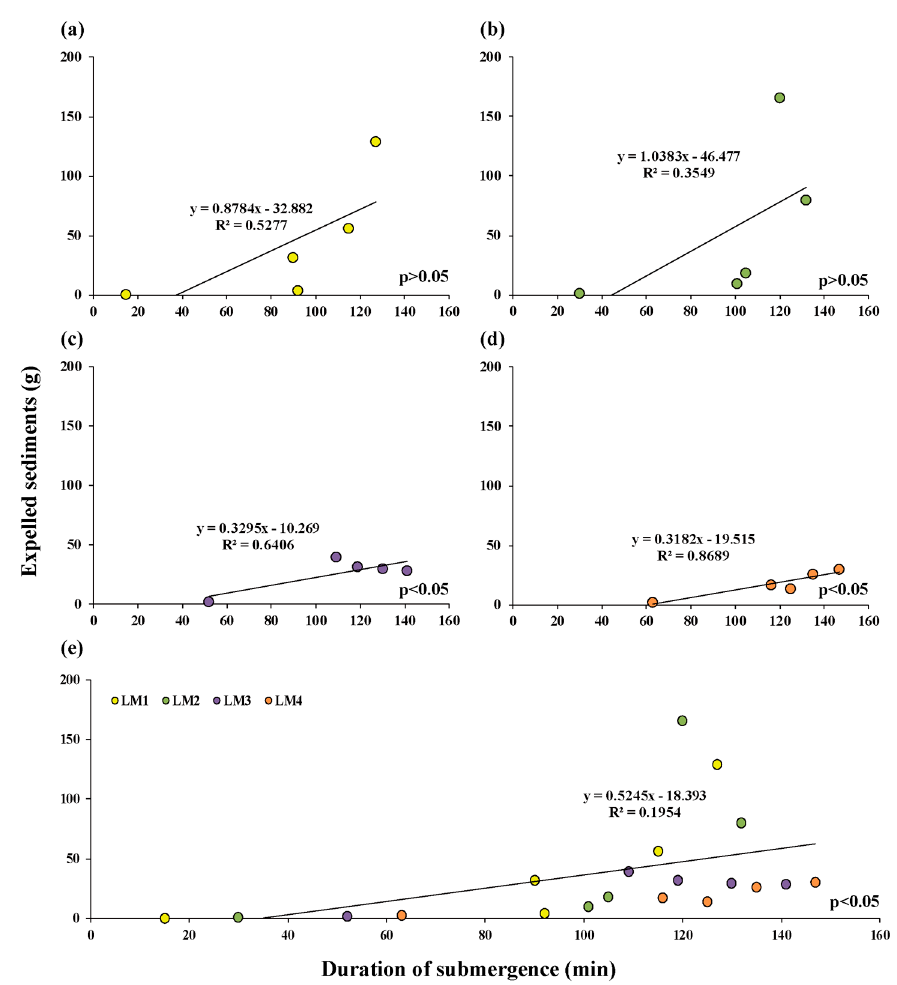
Figure 4. Correlation between SRR and duration of submergence at each burrow over the study period: ( a ) LM1, ( b ) LM2, ( c ) LM3, ( d ) LM4, and ( e ) all burrows.